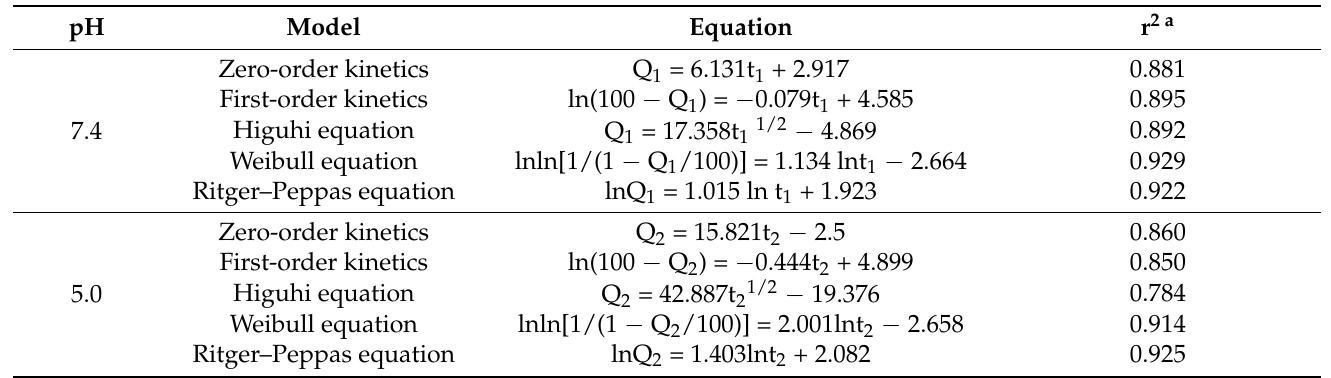
Table 4. Representative models used for describing kinetics of PTX